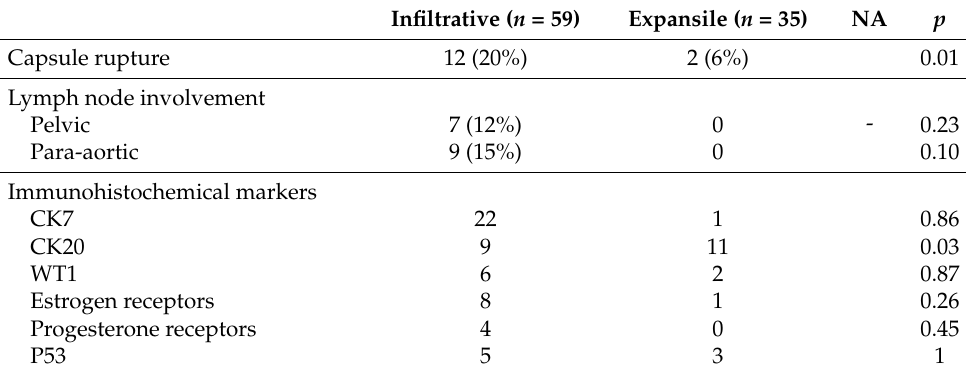
Table 3. Histological characteristics according to tumour type ( n =